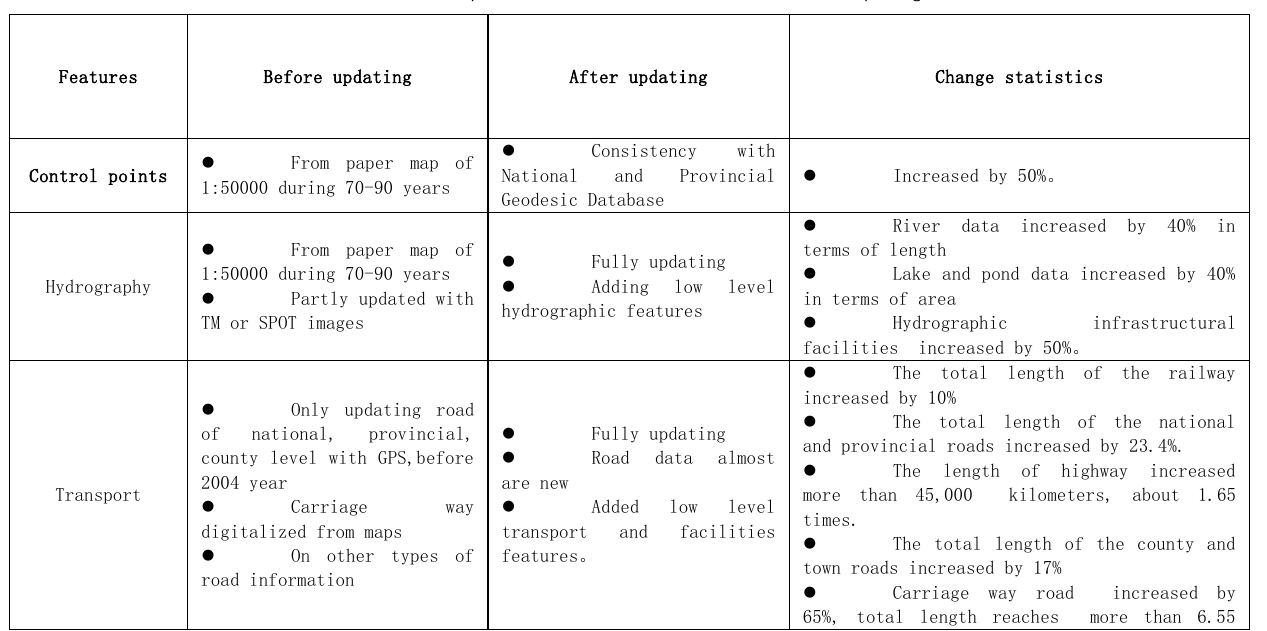
Table.2 Comparison of 1:50000 DLG between before and after